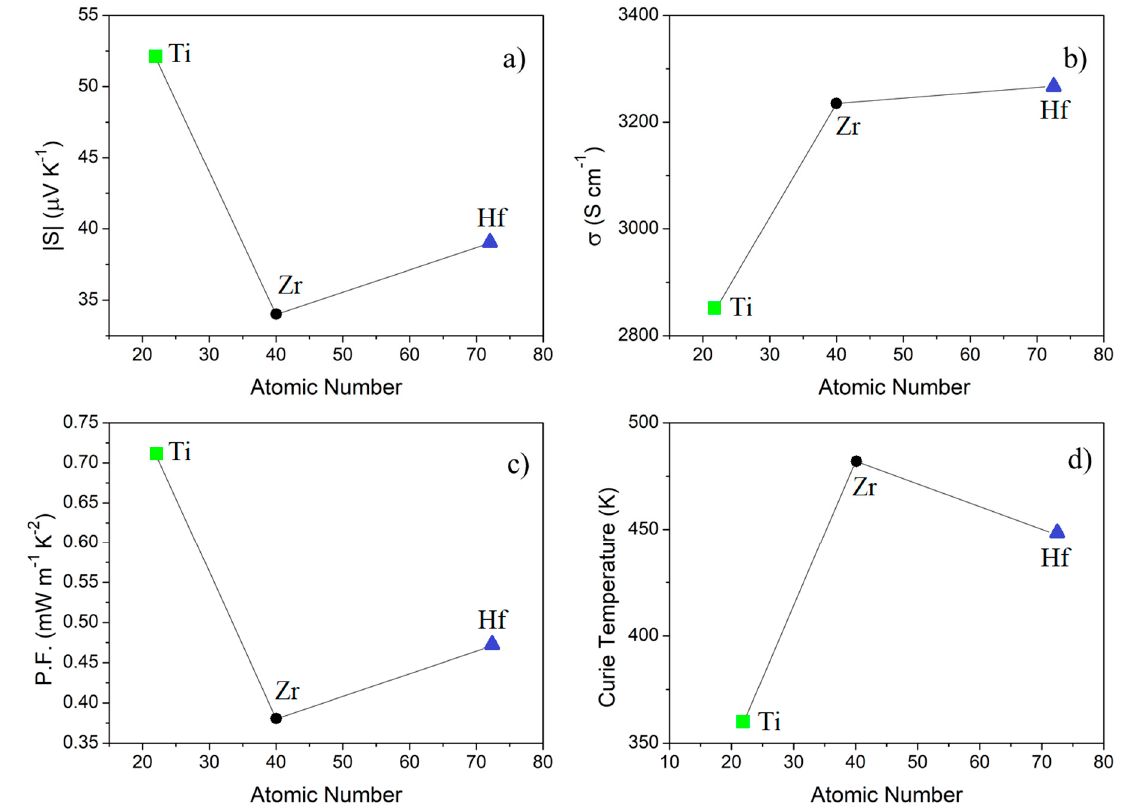
Figure 5. Trends of the transport properties ( a ): Seebeck coefficient; ( b ): electrical conductivity; ( c ): power factor) at 673 K, and Curie temperatures ( d ) of the Co 2 XSn (X = Ti, Zr, Hf) series of full-Heusler alloys as a function of the atomic number of the X element.